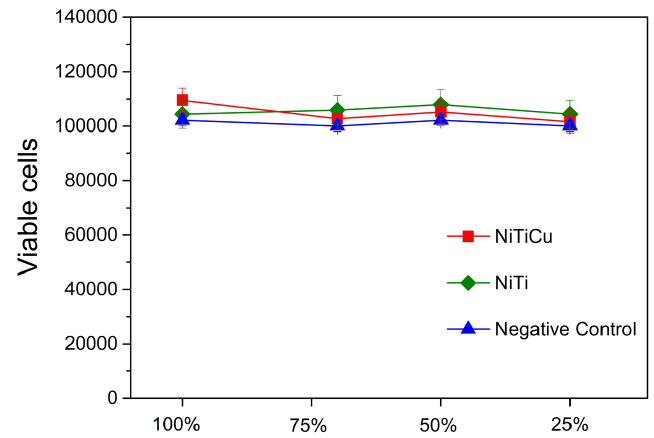
Figure 10. Viable cells in NR for NiTi and NiTiCu alloy compared to negative control